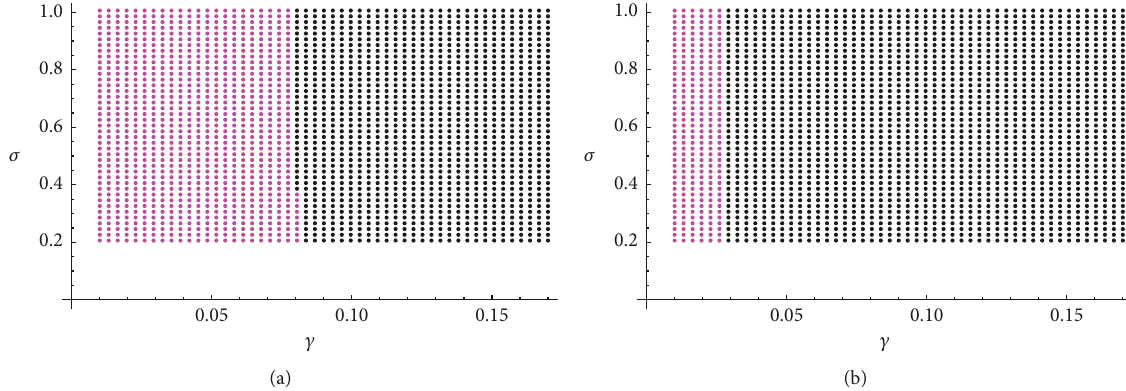
Figure 2: Critical regions (magenta – one critical value for 𝛽 ) and zero regions (black – no critical value for 𝛽 ), for 𝑟 = 10 −4 , 𝛼 = 10 −4 , 𝜀 = 10 −3 , and 𝑚 = 0.5 and (a) 𝑠 = 1.2 and (b) 𝑠 = 1.6